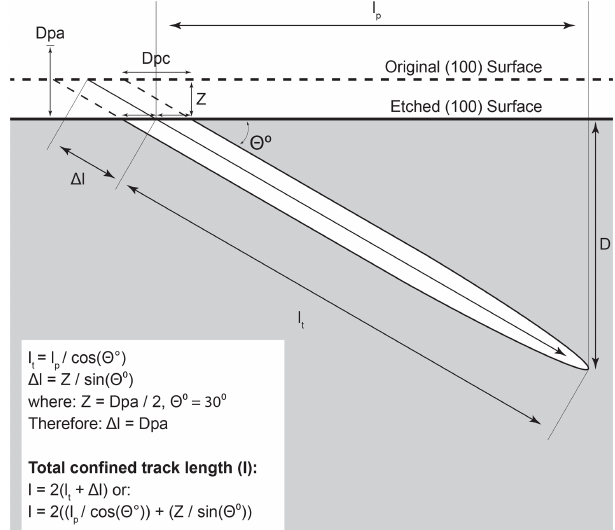
Figure 3. Illustration of the measurements and calculations re- quired to correct semi-track lengths for surface etching on a (100) face (i.e., parallel to b and c ). Bulk etching removes the original surface by approximately half the width of the etch pit diameter parallel to the a axis (Dpa) measured on the ∼ (001) face (modified from Ure